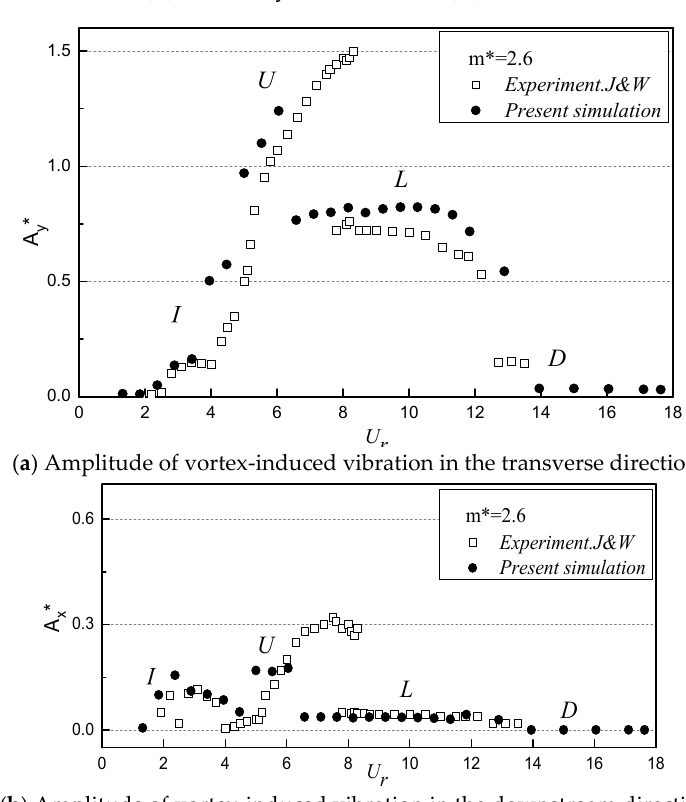
Figure 5. Comparison of non-dimensional amplitude with experimental results under different reduced velocities.